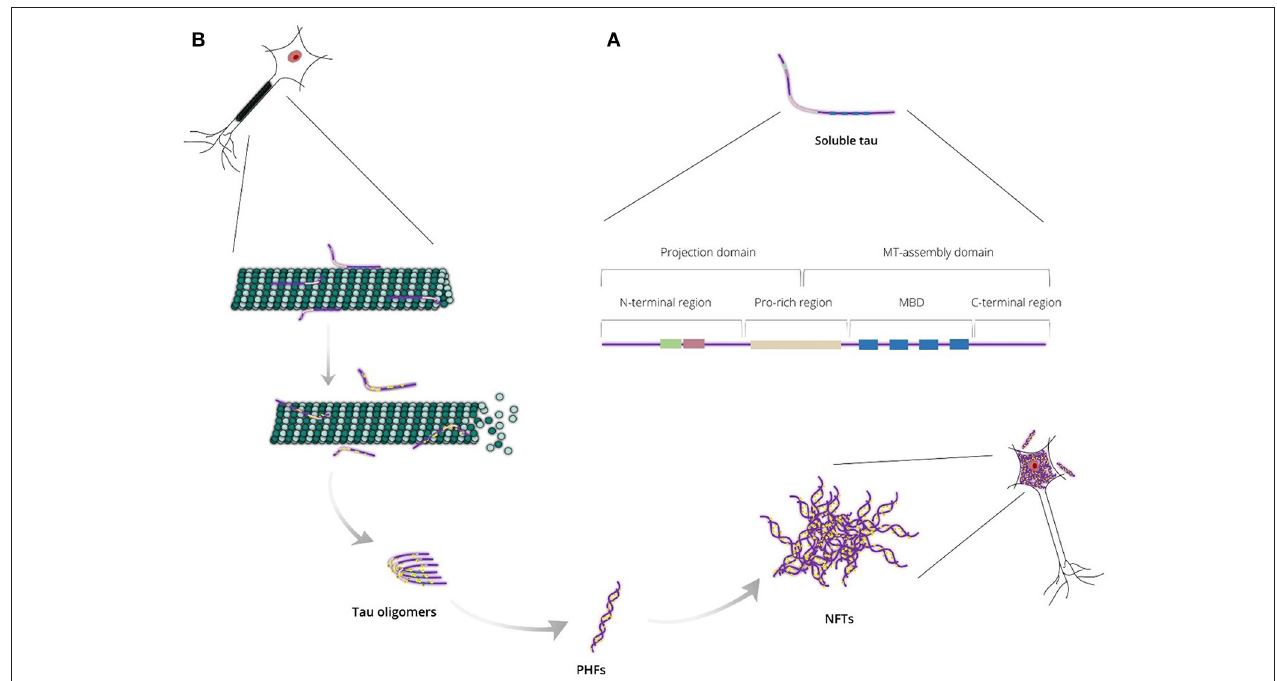
FIGURE 1 | (A) Endogenous tau is a highly soluble protein adopting an “unfolded” conformational state and consisting of two major domains: the projection domain that projects from microtubules and the microtubule (MT)-assembly domain that interacts with tubulin heterodimers. Tau can also be divided into four regions: the N-terminal region, the proline-rich (Pro-rich) region, the microtubule-binding domain (MBD) and the C-terminal region. (B) Tau is responsible mainly for stabilizing neuronal microtubules based on its phosphorylation state. Abnormal tau hyperphosphorylation weakens tau affinity for microtubules and, thus, releases tau in the cytosol and destabilizes the microtubule bundles. Unbound hyperphosphorylated tau assembles into pathogenic inclusions that deposit in brain tissues causing pathological